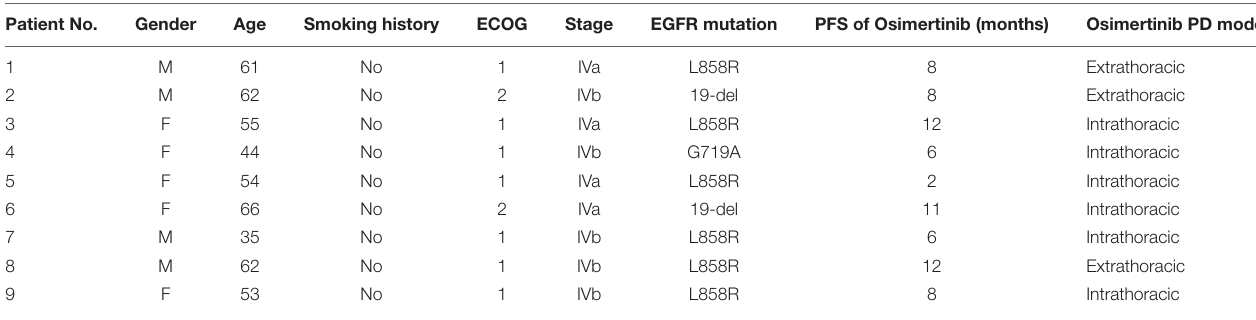
TABLE 2 | Basic characteristics of nine patients with NGS testing. Patient